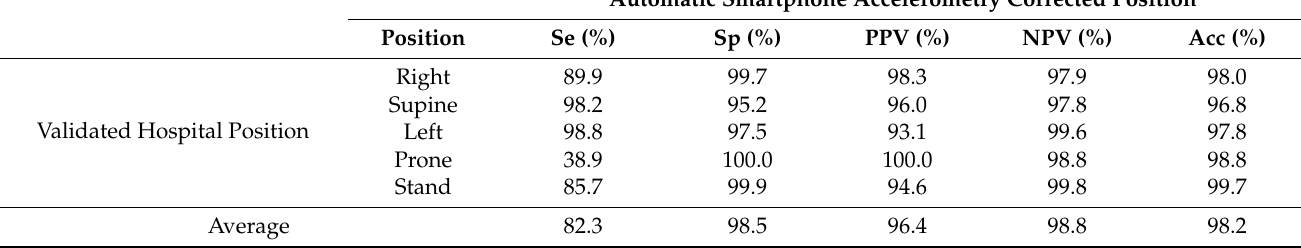
Table 4. Sensitivity (Se), specificity (Sp), positive predictive value (PPV), negative predictive value (NPV) and accuracy (ACC) of the comparison between automatic smartphone corrected position and validated PSG position.